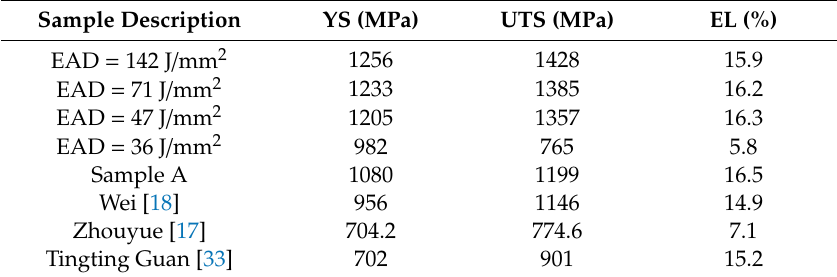
Table 5. Room temperature tensile properties of SLM low-alloy